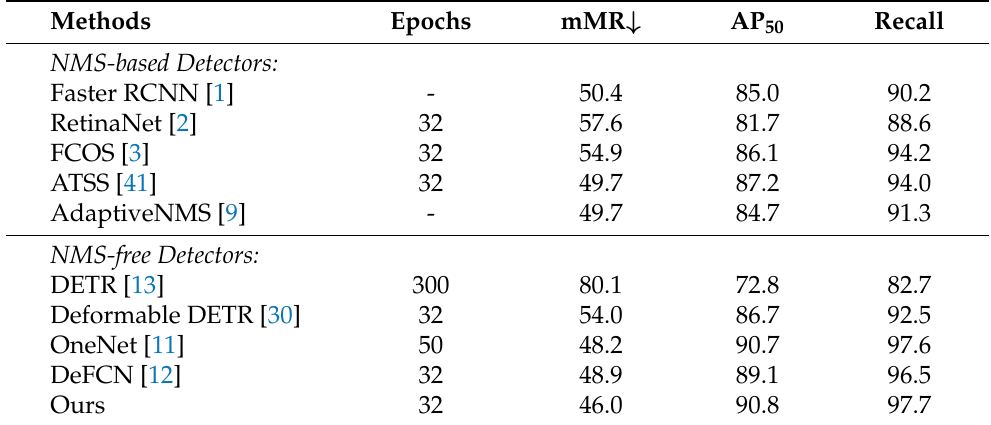
Table 3. Performance comparisons with the state-of-the-art object detectors on CrowdHuman val set. Note that the lower mMR is